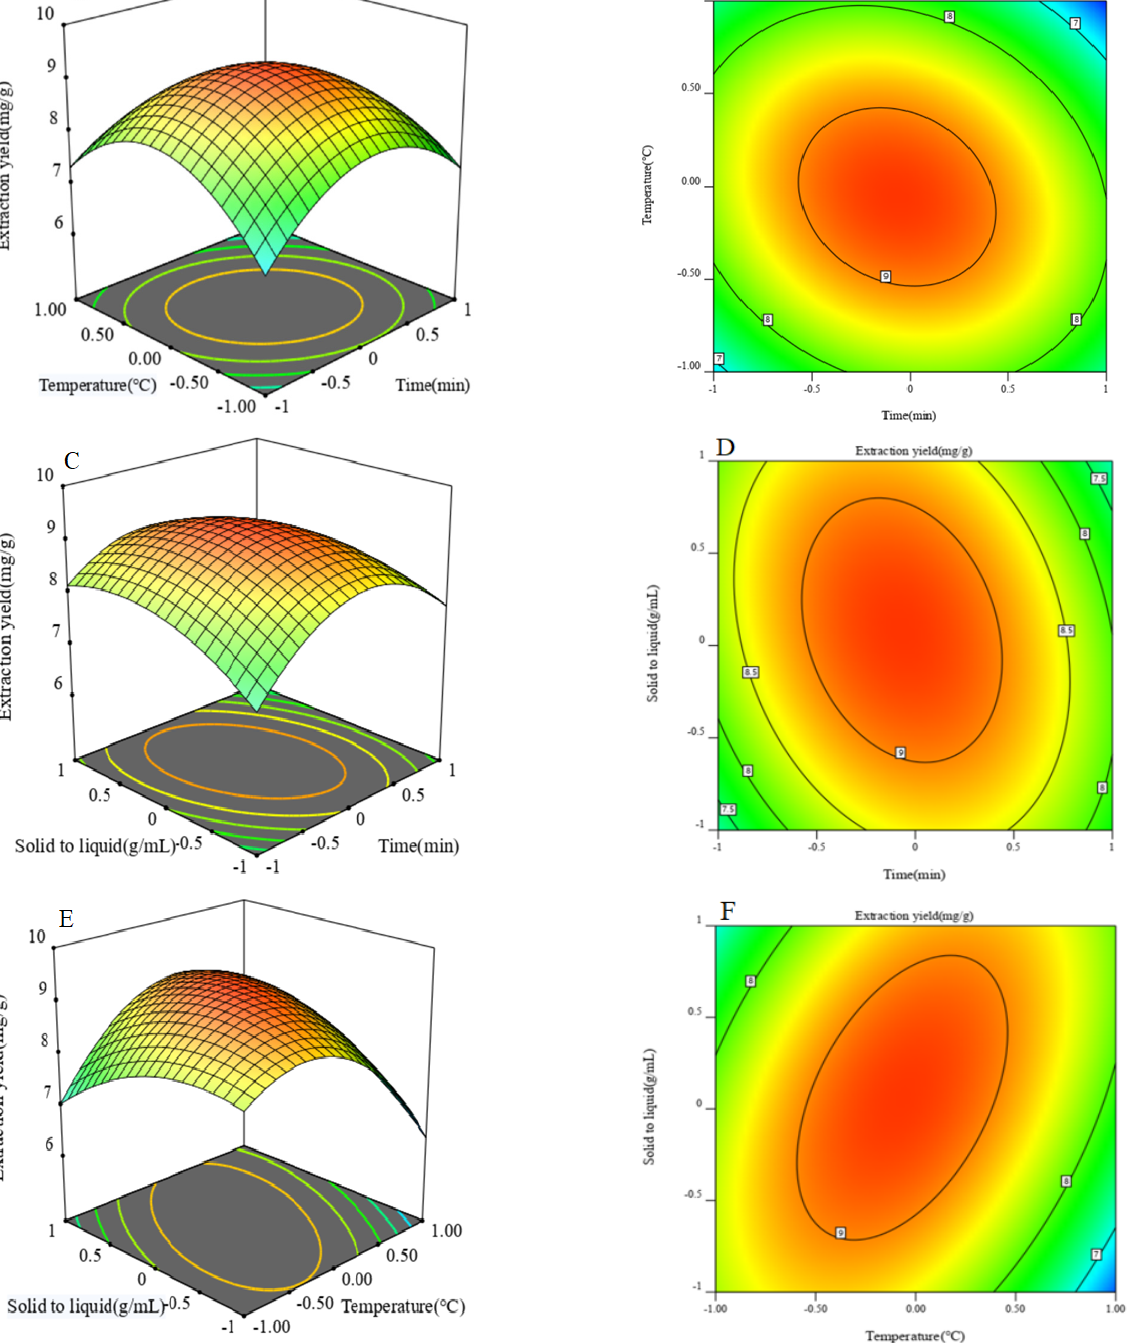
Figure 2. Response surface plots of the effects of factor interactions on phenols extraction yield: ( A ) Response surface of interaction between extraction temperature and extraction time; ( B ) The contour of interaction between extraction temperature and extraction time; ( C ) Response surface of interaction between the solid-to-liquid ratio and extraction time; ( D ) The contour of interaction between the solid-to-liquid ratio and extraction time; ( E ) Response surface of interaction between the solid-to-liquid ratio and extraction temperature; ( F ) The contour of interaction between the solid-to-liquid ratio and extraction